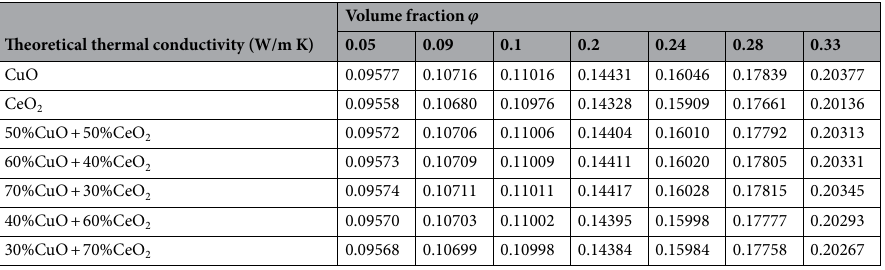
Table 7. Theoretical thermal conductivity of the nanorefrigerant.